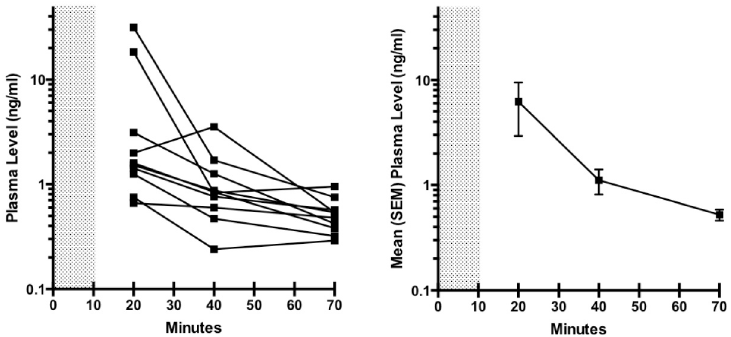
Fig 3. Dexmedetomidine plasma levels after bolus administration. Dexmedetomidine plasma levels in individual subjects (A), and mean with SEM levels for the entire group (B). After the 1 μ g/kg bolus infusion, levels were 0.3 ng/ml or higher in all subjects for at least 60